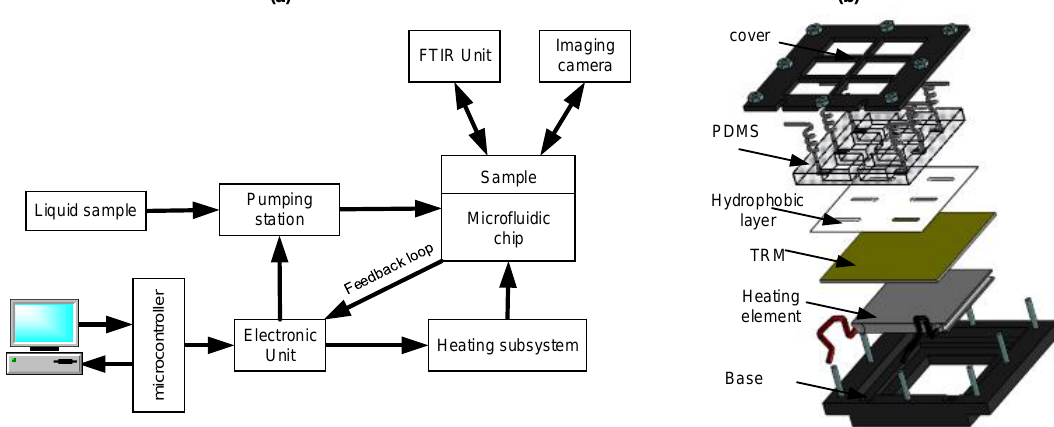
Figure 3. ( a ) Functional diagram of the entire system. ( b ) Microfluidic chip with heating